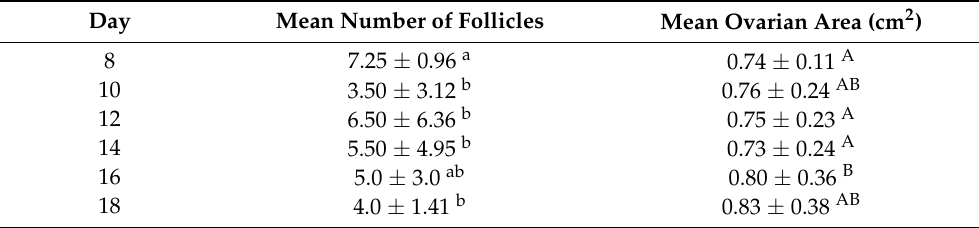
Table 1. Mean ( ± SD) number of clearly identifiable fluid-filled structures on both ovaries and area of the ovaries from day 8 to day 18 after deslorelin treatment. Different superscripts of the mean number of follicles ( a , b ) and the mean ovarian area ( A , B ) differ significantly ( p <